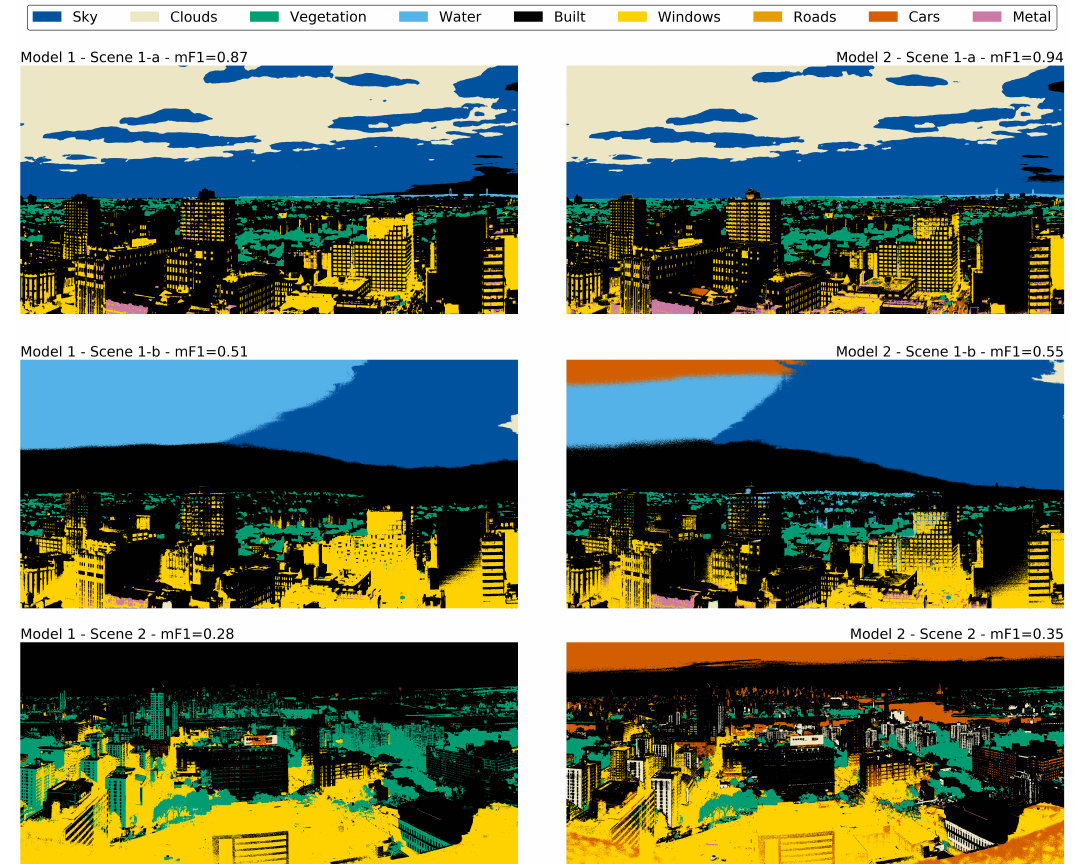
Figure 9. Image segmentation result from Models 1 ( left ) and 2 ( right ) trained on Scene 1-a ( top ) and applied to Scene 1-b ( middle ) and Scene 2 ( bottom ). The model architectures and hyperparameters are shown in Figure 4 (although spatial information is not used when transferring models between